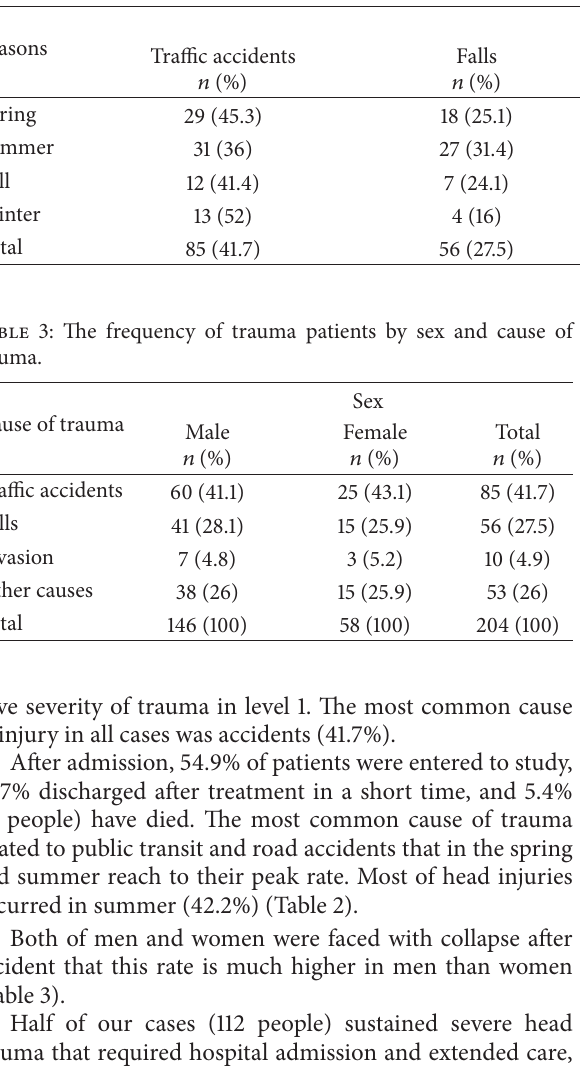
Table 2: Distribution of trauma patients by season and mechanism of trauma.